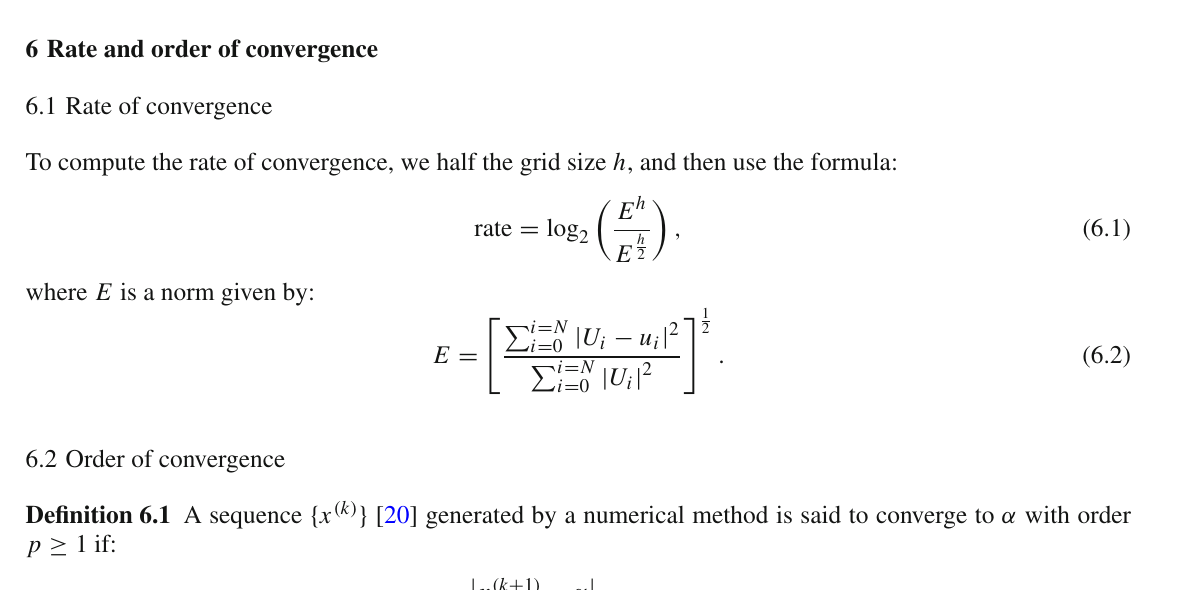
Fig. 6 I-EFD solution of Example 5.3 for (cid:2) t = 0 . 05 and (cid:2) x = 0 .